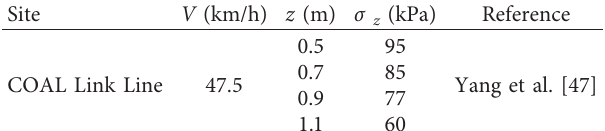
Table 4: Database of railway field measurements in South Africa.